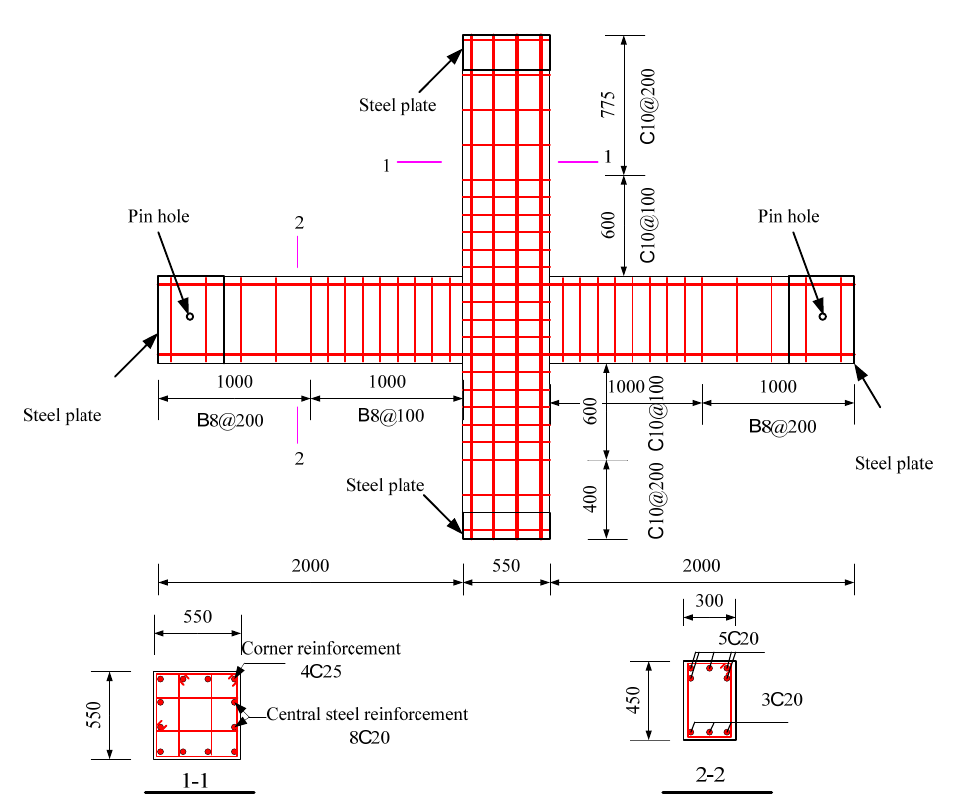
Figure 1. The design details of XJ (Unit: mm). Note: B = HRB335, HRB335 represents steel bars with a strength grade of 335 MPa; C = HRB400, HRB400 represents steel bars with a strength grade of 400 MPa.